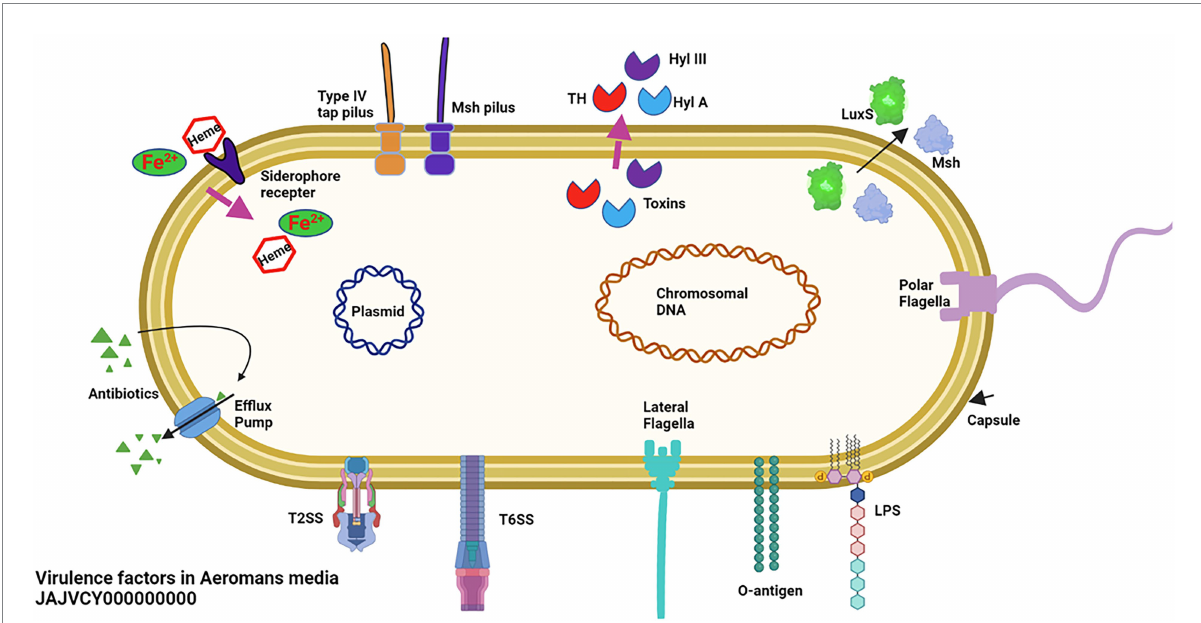
FIGURE 3 Schematic diagram of virulence genes on Aeromonas media included investigated showing (i) adherence proteins consisting of the Msh and type tap IV pili as well as the polar and lateral flagella, (ii) iron acquisition components comprising of the ferric uptake regulator ( Fur ), heme, and siderophore proteins, (iii) secretion system consisting of T2SS and T6SS, (iv) hemolysins consisting of hemolysin A ( hylA ), hemolysin III ( hylIII ), and thermostable heat (TH) protein, (v) biofilm and quorum sensing components consisting of S - ribosylhomocysteinase ( LuxS ) and MQS, (iv) Immune proteins consisting of capsule, lipopolysaccharide (LPS), and somatic O-antigen. In addition, schematic diagram shows A . media components associated with antimicrobial resistance (AMR) components consisting of (vii) efflux pumps and (viii) plasmid. Figure 3 was created in BioRender.com